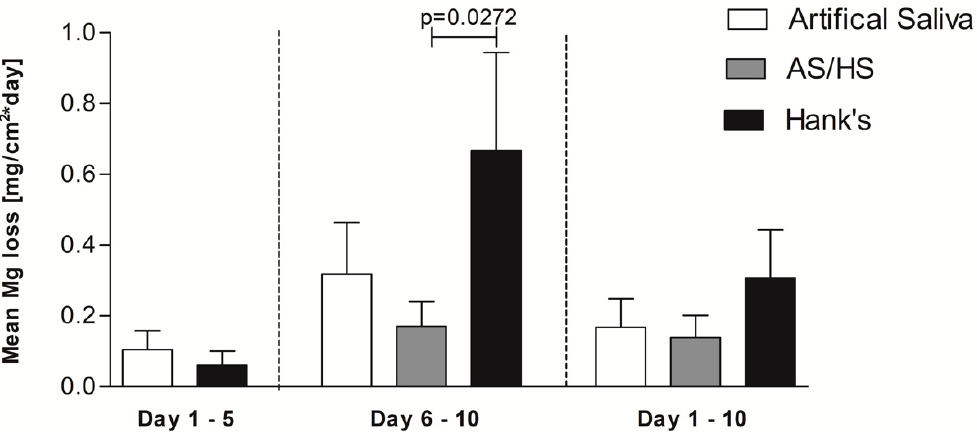
Figure 2. Displayed are the calculated corrosion rates as mean magnesium loss per day of Mg-0.6Ca-0.8Zn wt.% either for day 1–5, day 6–10 after the electrolyte change or for day 1–10. Each experiment was repeated at least 3 times. Values are shown as means plus standard deviation. Table 2. Shown are the calculated corrosion rates as mean Magnesium loss per day of Mg-0.6Ca-0.8Zn wt.% with standard deviation either from day 1–5, after the electrolyte change (day 6–10) or from day 1–10.